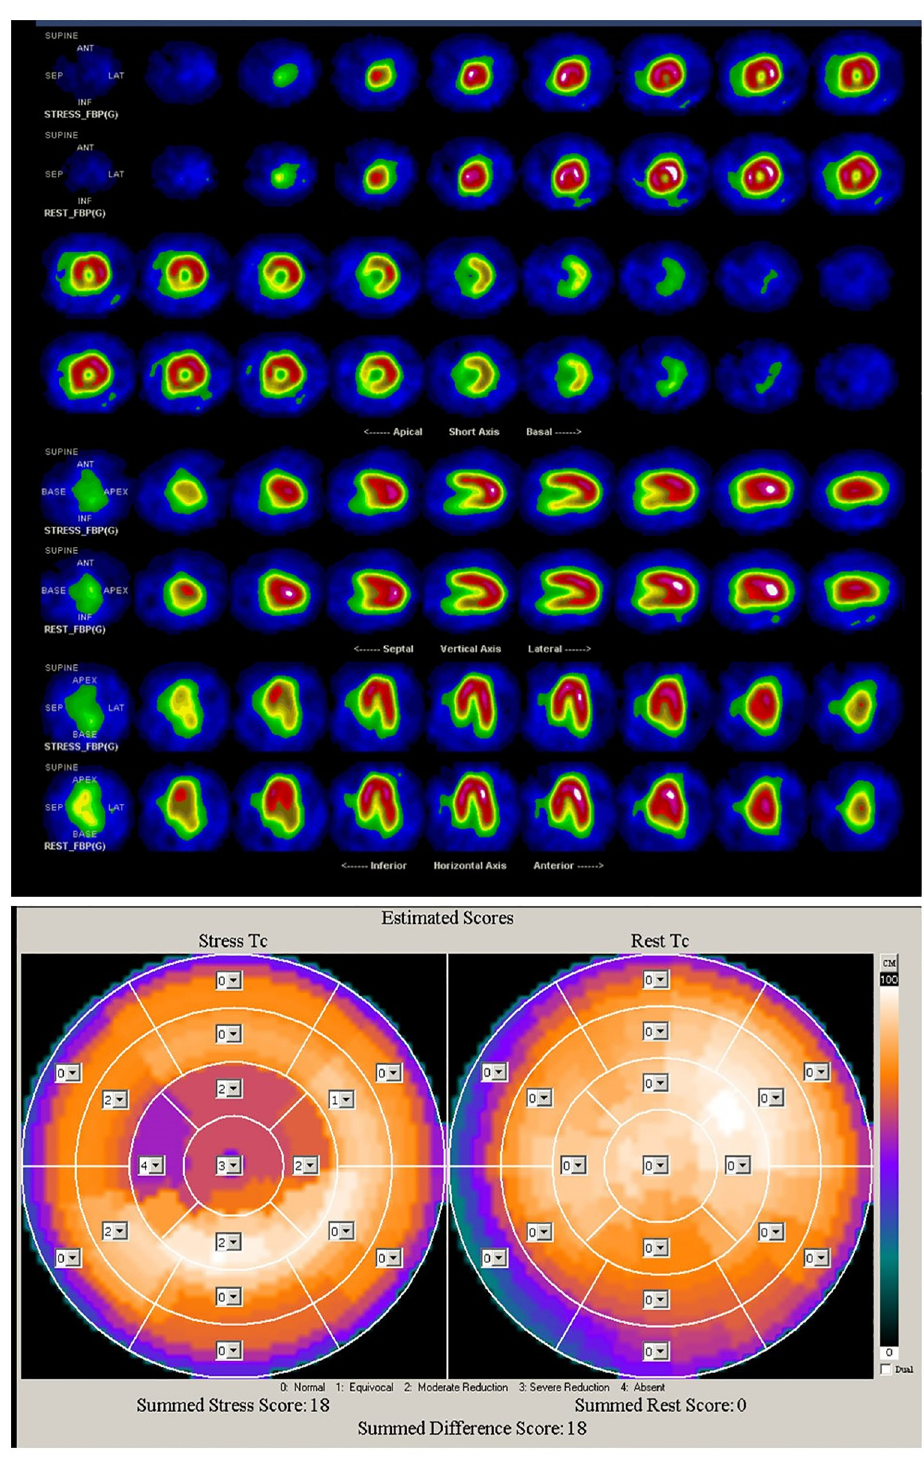
Fig 6. SPECT MPI results of GB0880. The rest and stress SPECT ischemia score of GB0527 are 0 and 18, respectively.